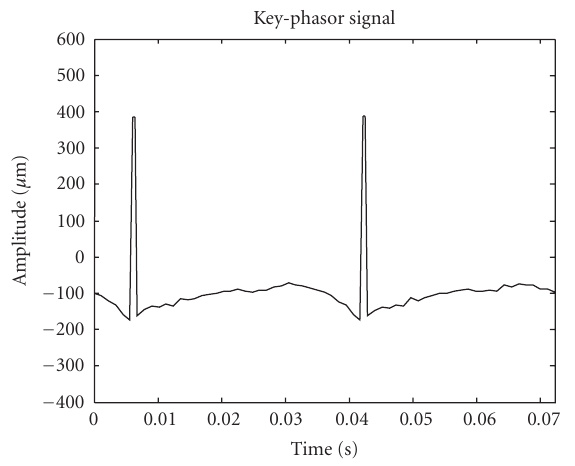
Figure 5: Time history of the lateral vibrations measured by the key-phasor probe at the beginning of the rub phenomena. Rotating speed: 1660 rpm.